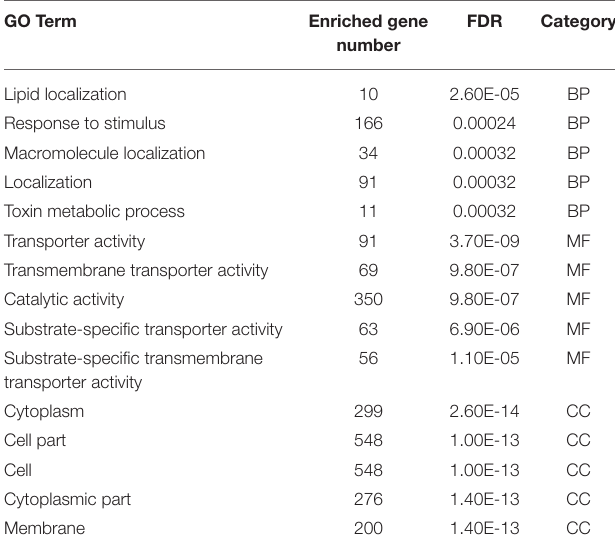
TABLE 3 | Top five significant GO terms in the sub-category of biological progress (BP), molecular function (MF), and cellular component